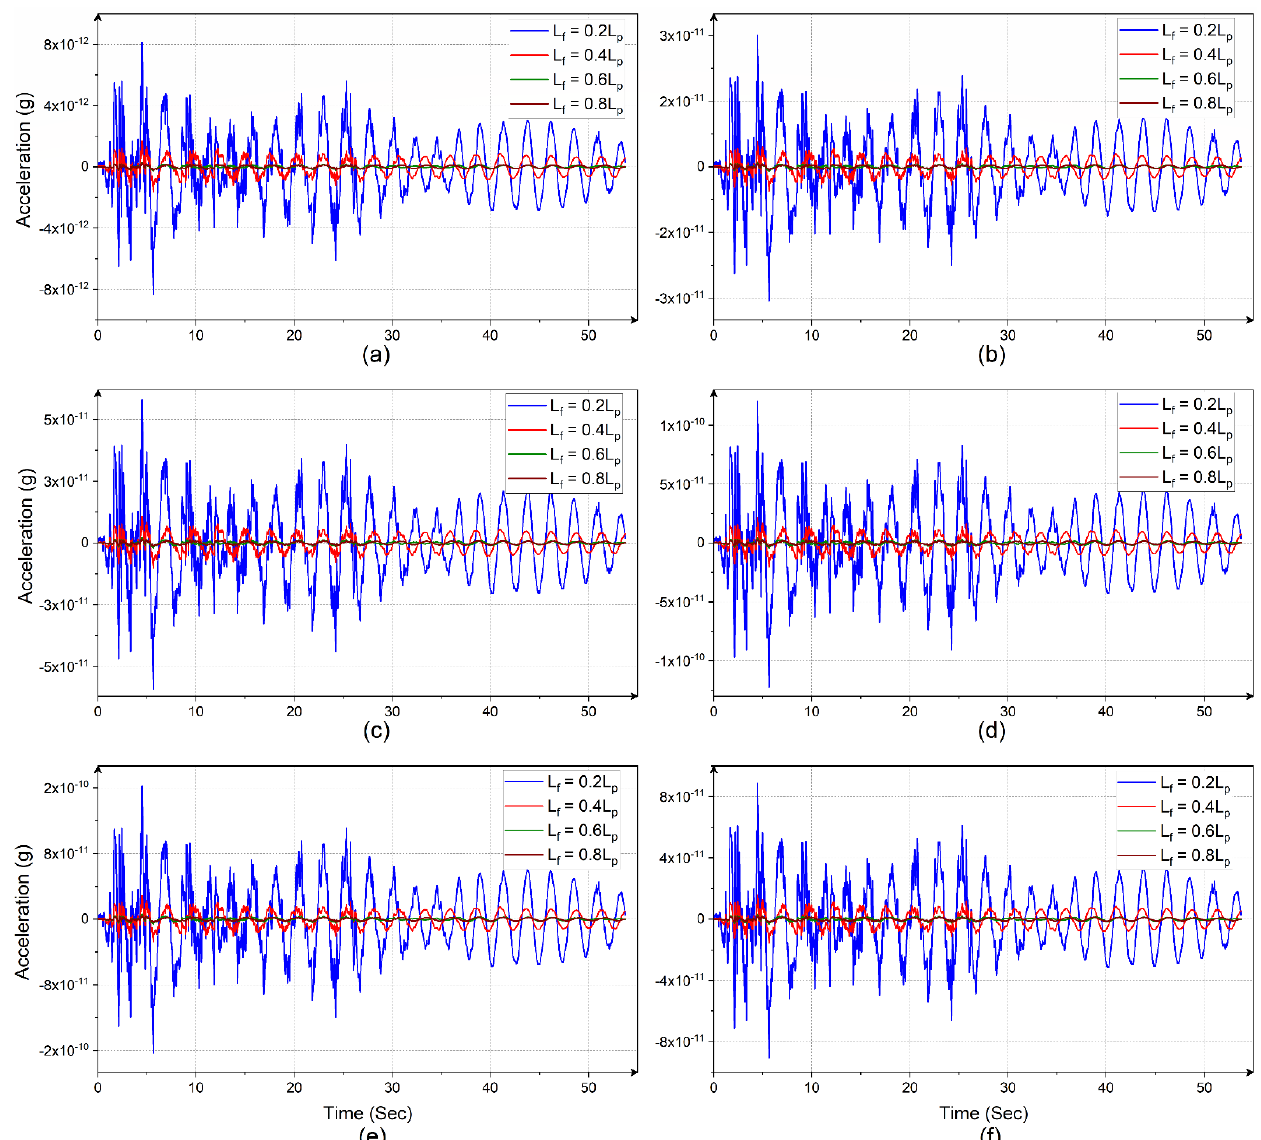
Figure 10. Time – history plots of the FP-Mats for the various floor-levels of the multi-story building: ( a ) Base Floor; ( b ) Floor-05; ( c ) Floor-10; ( d ) Floor-15; ( e ) Floor-20; and ( f ) Floor-25.